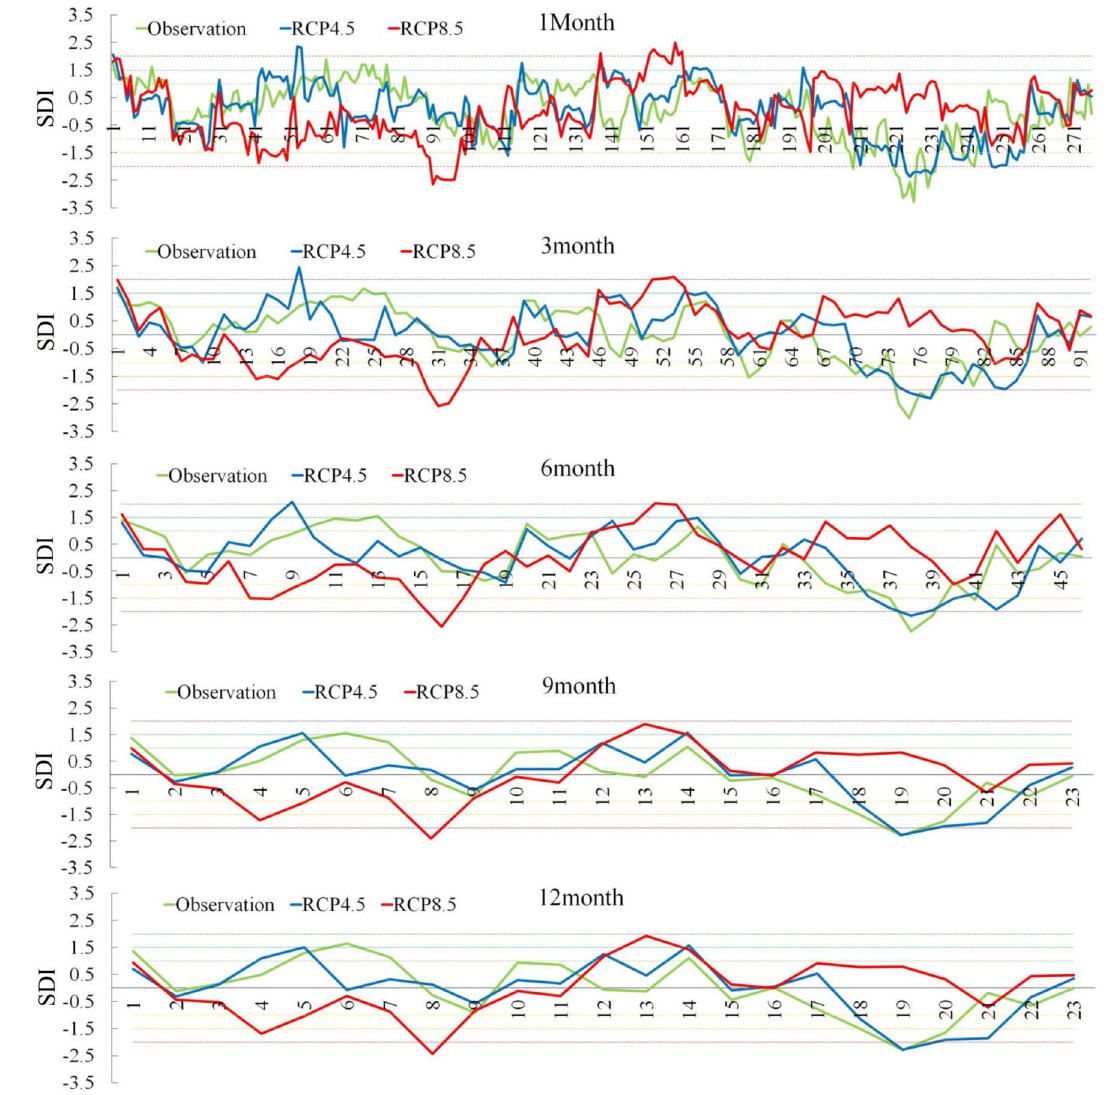
Fig. 13 Short-term, middle-term, and long-term SDI in the baseline period and future period under the scenarios (RCP4.5 and